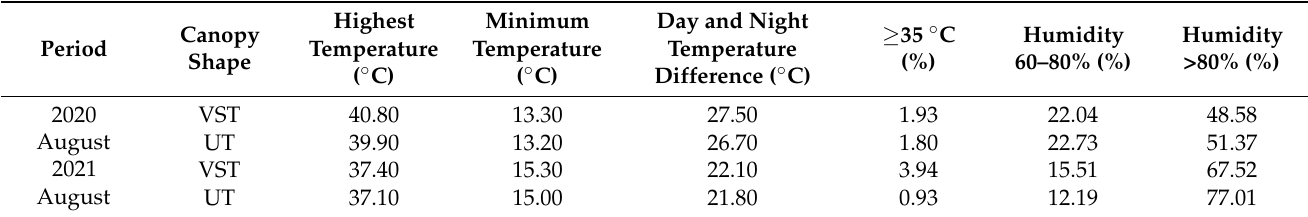
Table 1. Effect of canopy types on the temperature and humidity around grape